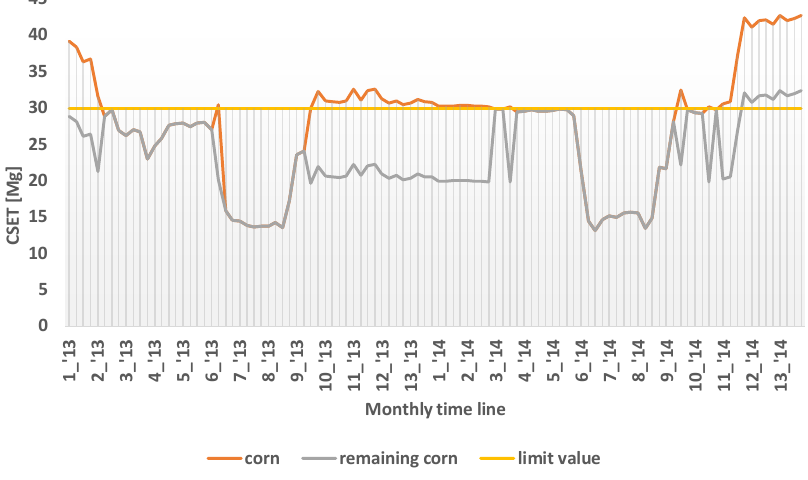
Figure 8. Corn required in the weeks exceeding the threshold value within S3. Table 1. Summary of the three scenarios.